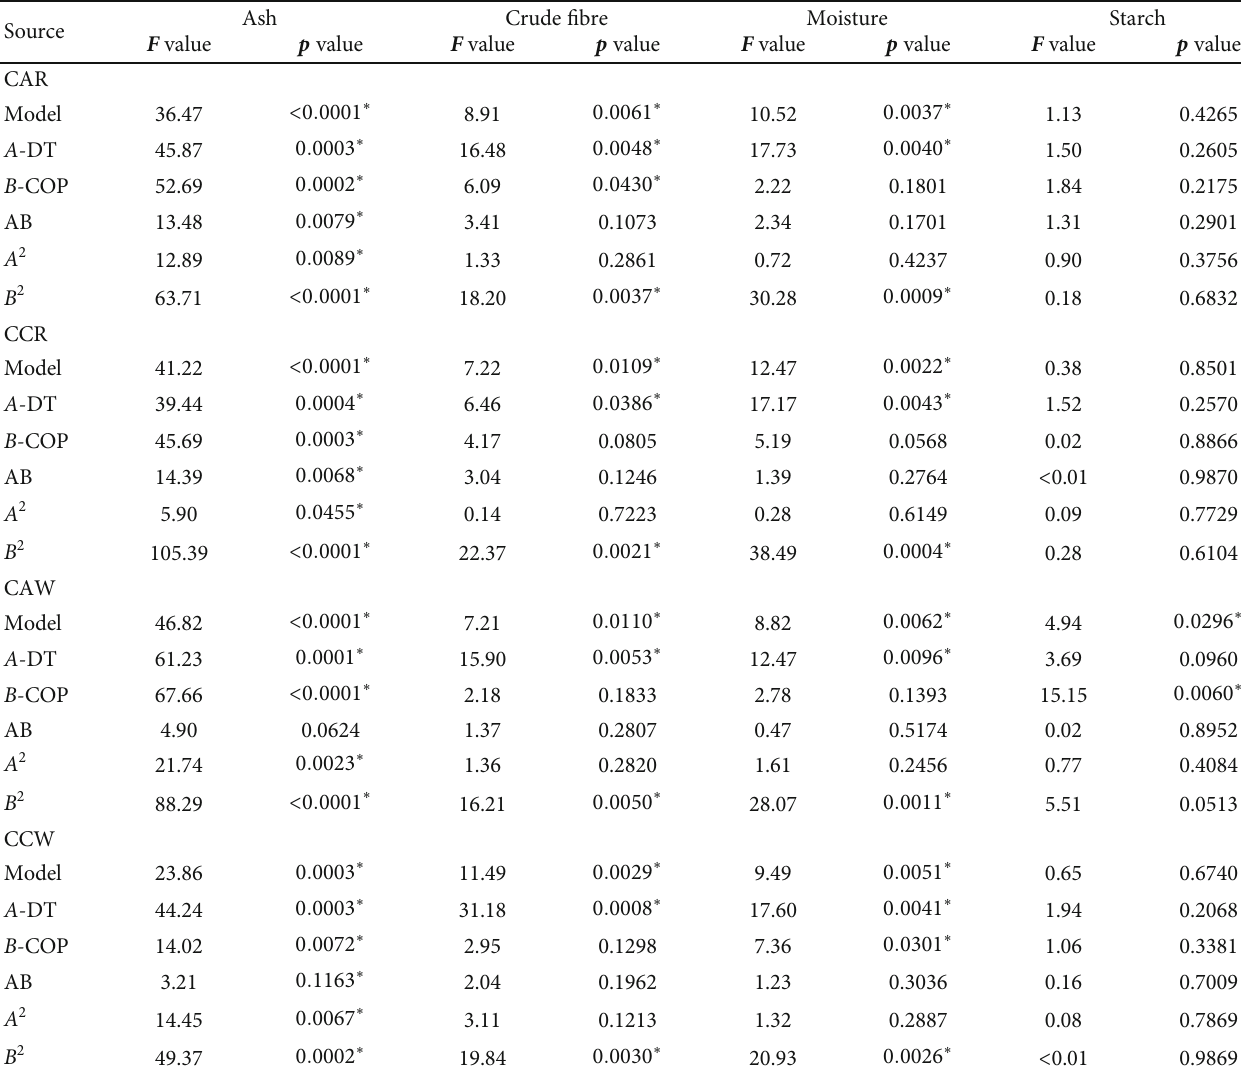
Table 2: ANOVA of the e ff ect of model parameters on proximate components of cassava fl